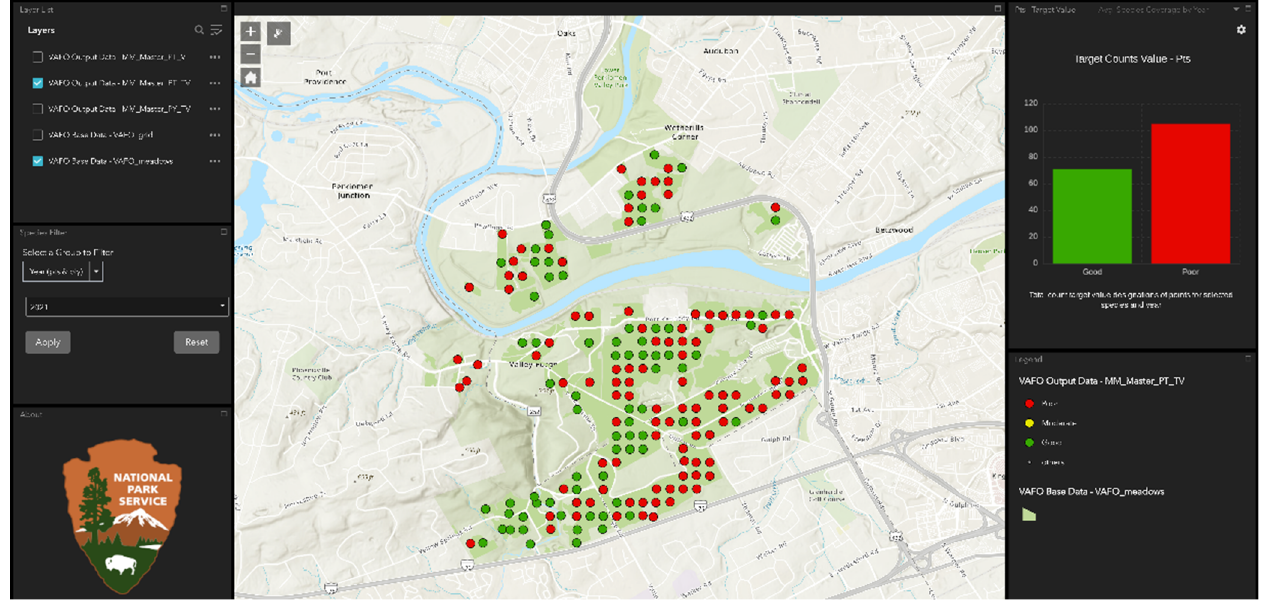
Figure 6. The GMMT online tool shows a representation of forb coverage benchmarks. The green represents points indicating “good” benchmarks, while the red indicates “poor” benchmarks. Top right shows the total count of points for each benchmark.